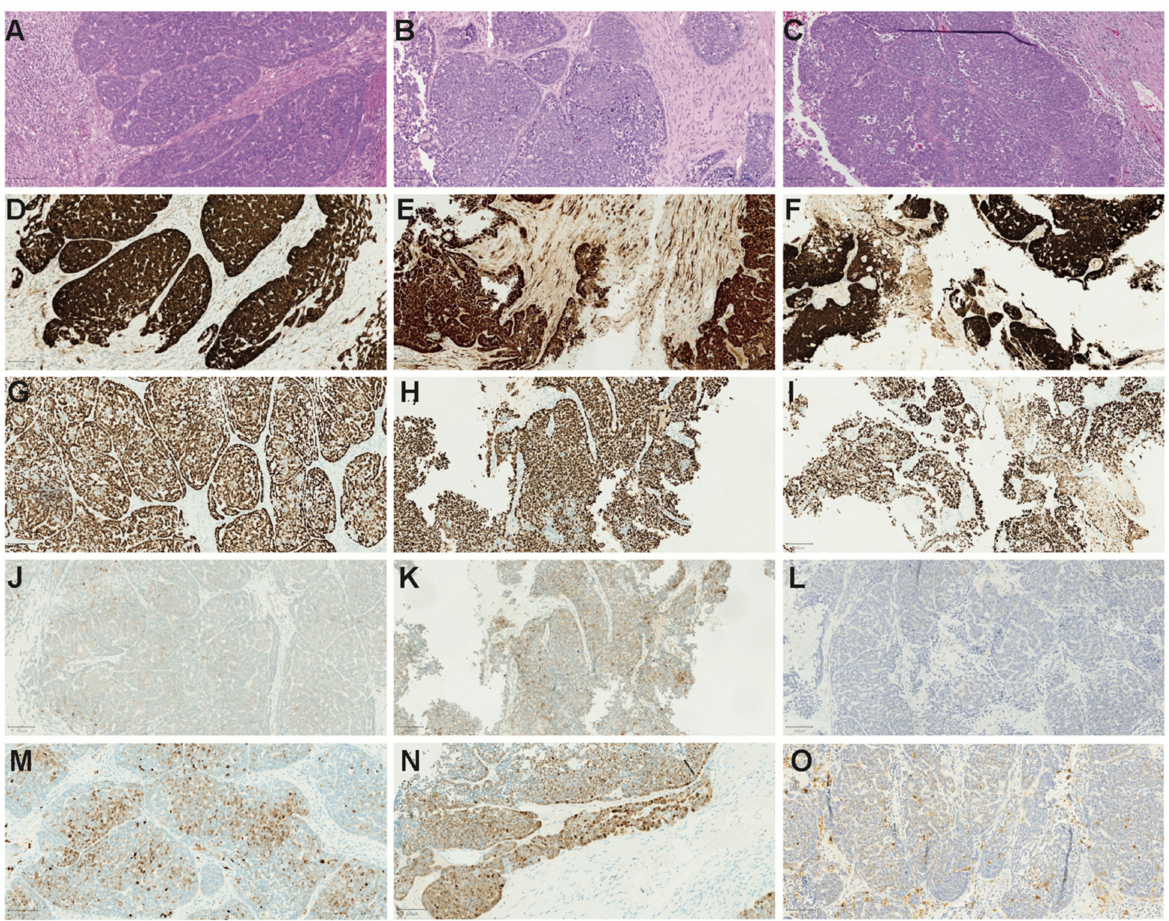
Figure 1. Tumour sections from patients with HPV DNA-positive tumours that were initially diag- nosed as adenoid cystic carcinoma stained with haematoxylin–eosin (HE) and immunohistochemical markers. ( A – C ) HE. ( D – F ) p16. ( G – I ) p63. ( J – L ) CD117. ( M – O ) S100. All tumours showed